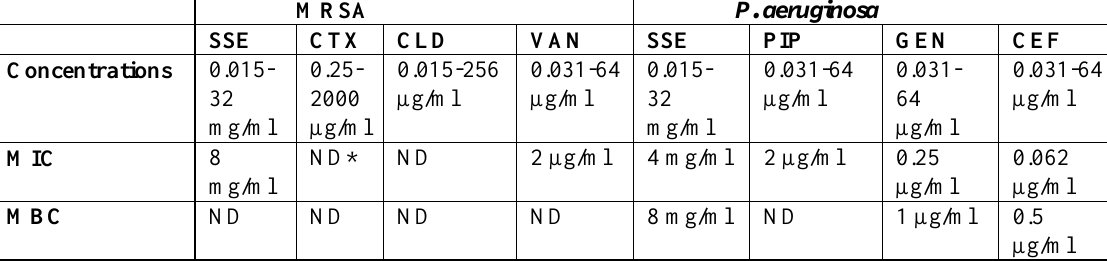
Table 1. The antibacterial activity of antibiotics and S. striata extract